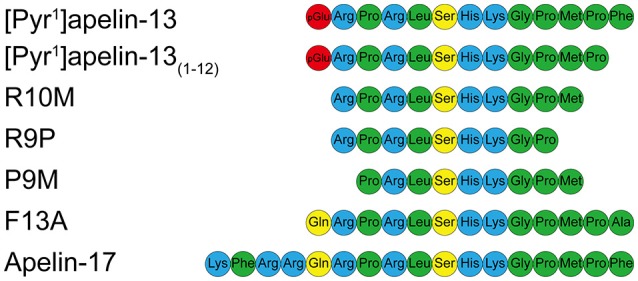
Aligned amino acid sequences of apelin peptides. Hydrophobic amino acids are shown in green, uncharged polar amino acids in yellow, basic amino acids in blue and pyroglutamate in red.